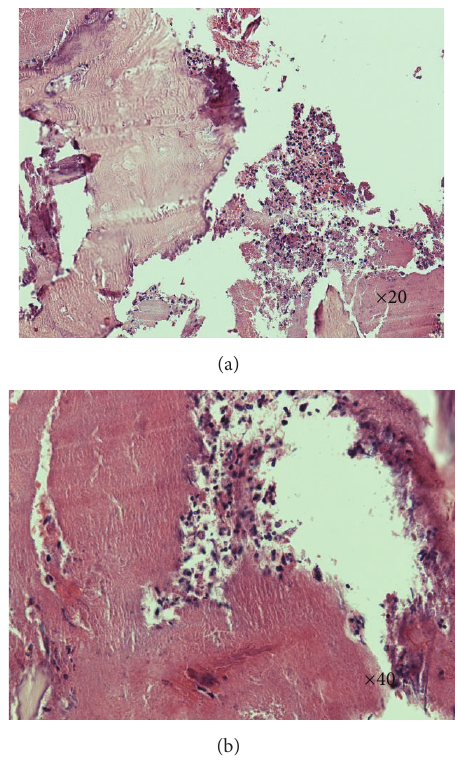
Figure 2: (a, b) H&E section showing necrotic bone and acute inflammation (courtesy of Dr. David Clark, Department of Pathol- ogy, Lincoln County Hospital, United Lincolnshire Hospitals NHS